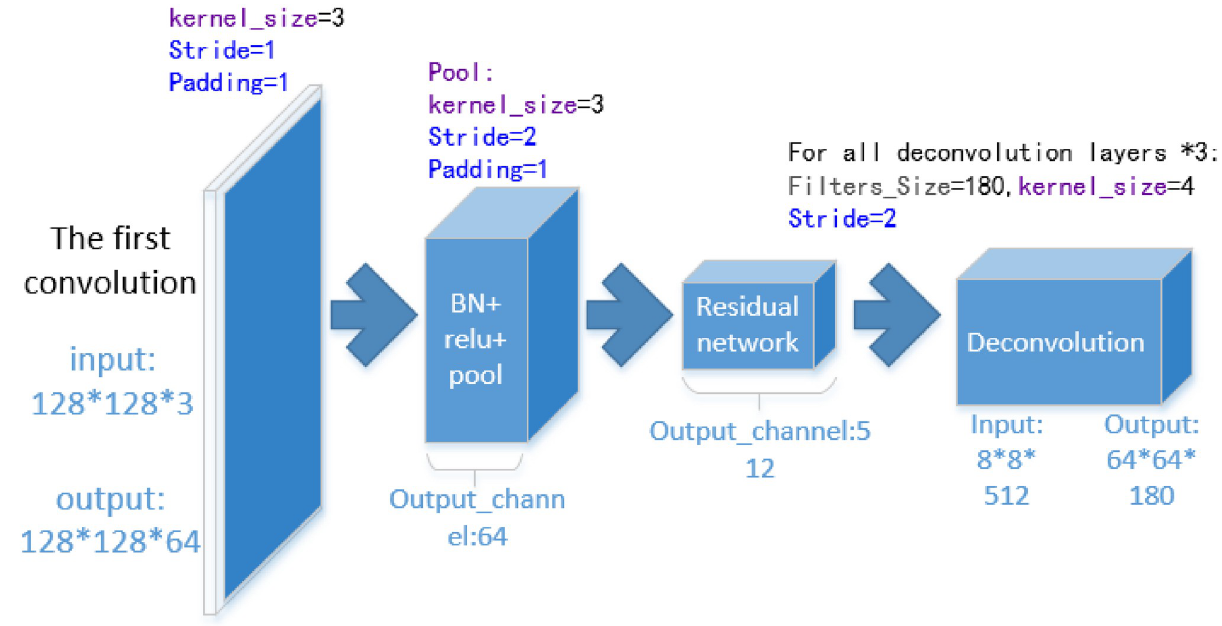
Fig 6. The structure of the RDNS deep